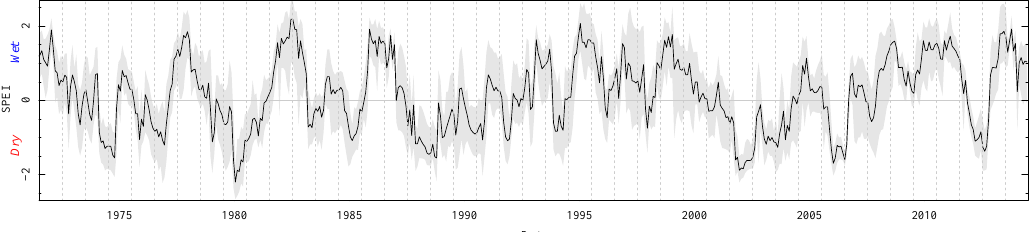
Figure 4. The record of 9 month SPEI in the study area. The grey area shows the range of SPEI covered by the 20 half-degree SPEI pixels within the study area; the black line is the average value for the 20